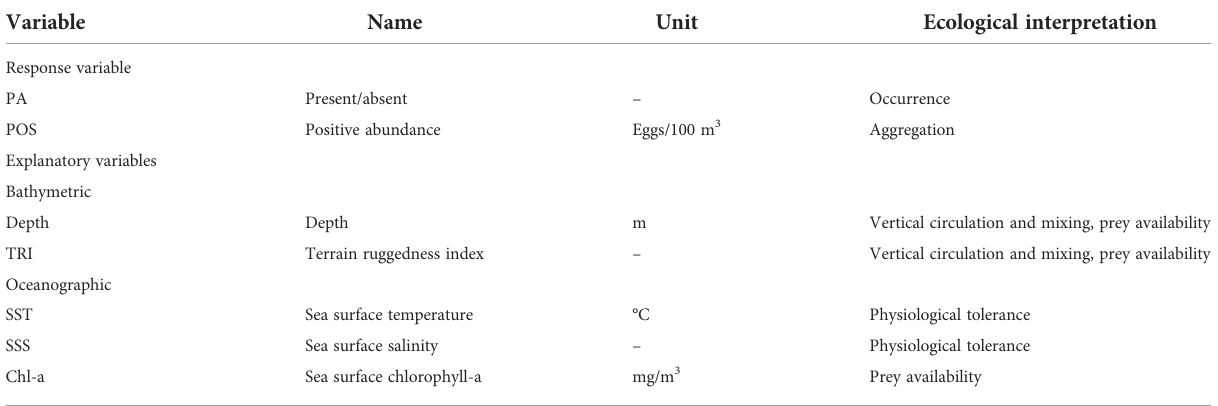
TABLE 2 Summary of the egg-predictor used in the establishment of the occupancy and abundance-habitat models, covering information on the description, unit, and potential ecological meaning. Variable